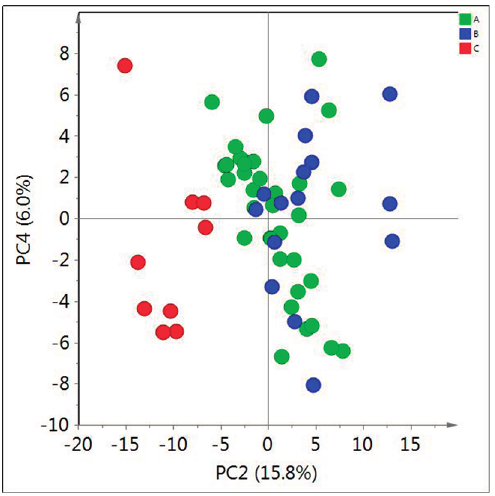
Figure 5. Score plot of principal component analysis (PCA, PC2/PC4) obtained from 1 H-NMR data of in CD 3 OD extracts of 2–3 year old Astragalus membranaceus var. mongholicus (A); Asgragalus membranaceus (B); and Hedysarum polybotrys